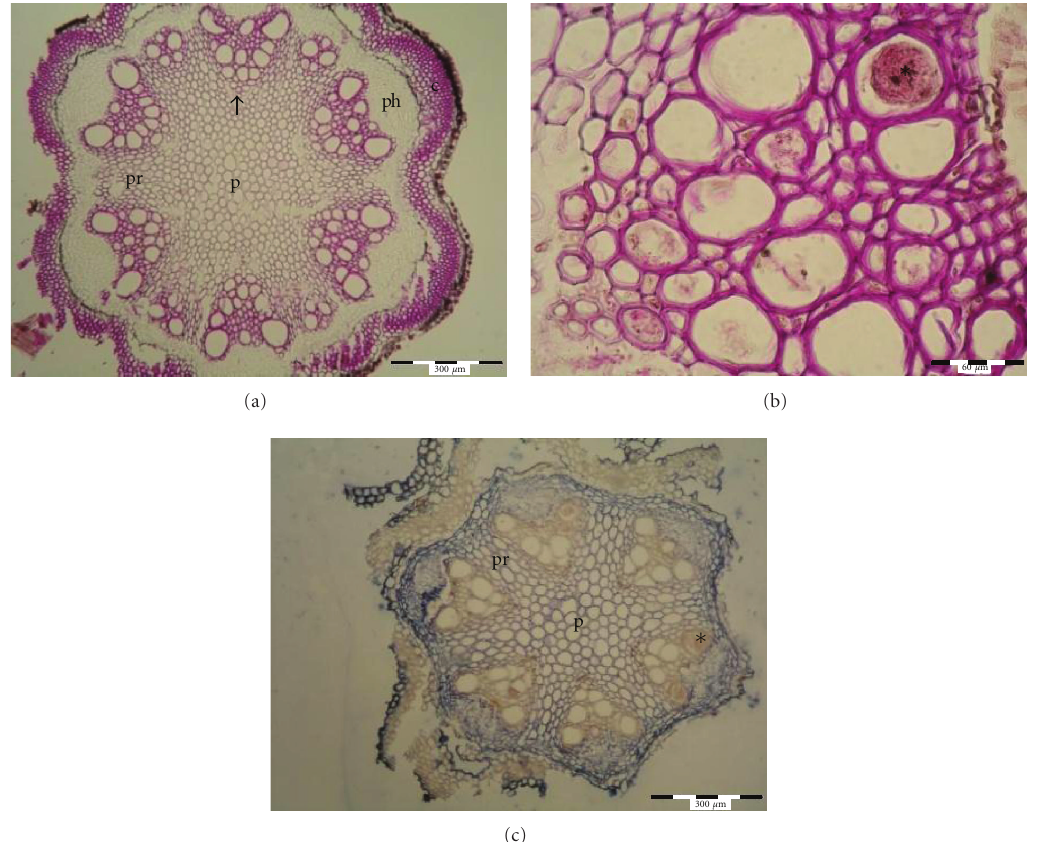
Figure 4: Histochemical identification of polysaccharide components and homogalacturonan epitopes in xylem occlusions in stems of Clematis “Solidarno´s´c” by using PAS reaction and Jim5 antibody. (a) and (b) Identification of polysaccharide components in xylem of control stems (a), stems kept in distilled water (b), (c) identification of homogalacturonan epitopes in xylem of stems kept in distilled water. C: cortex with lamellar collenchyma, p: pith, pr: pith rays, ph: phloem, arrow: xylem vessel, ∗ : blocked xylem